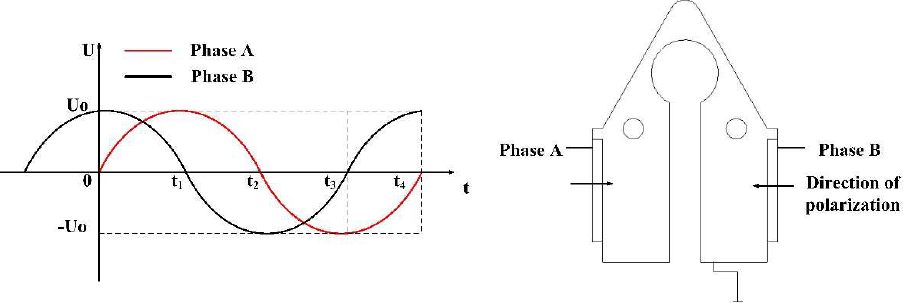
Figure 3. Polarization and excitation signals of the stator.